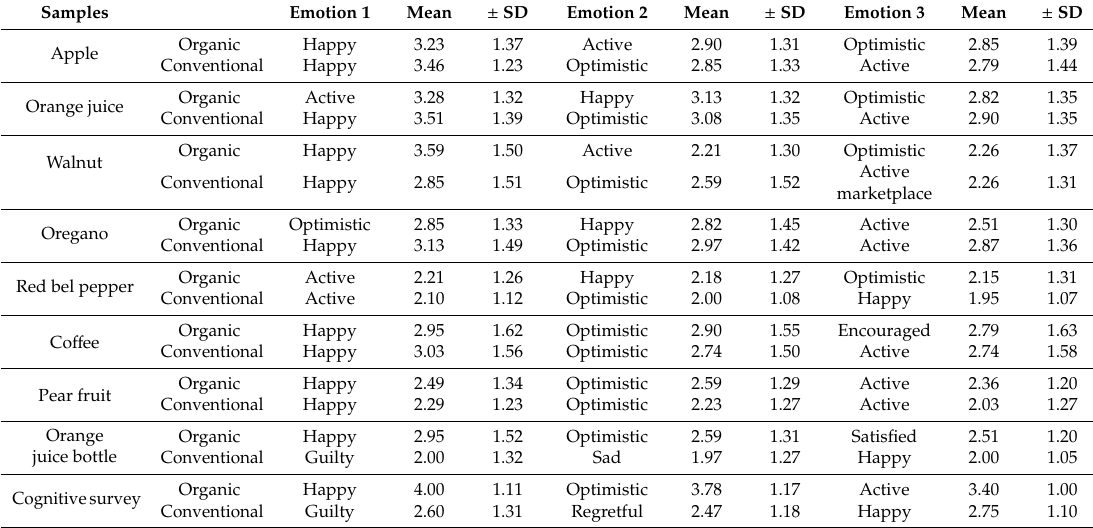
Table 3. Mean values ( ± SD) of the highest three rated emotion terms (active, satisfied, optimistic, proud, happy, encouraged, guilty, ashamed, angry, sad, regretful, scared, and angry), on a 5-point scale (1 = I do not feel it at all, 5 = I strongly feel it), that were used to express the food-elicited emotions in the emotional profiling and the food-declared emotions in the cognitive